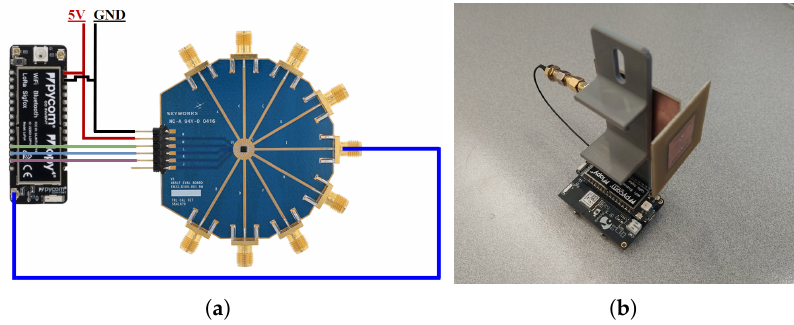
Figure 11. ( a ) Block diagram of BS circuitry and ( b ) photography of the SN.